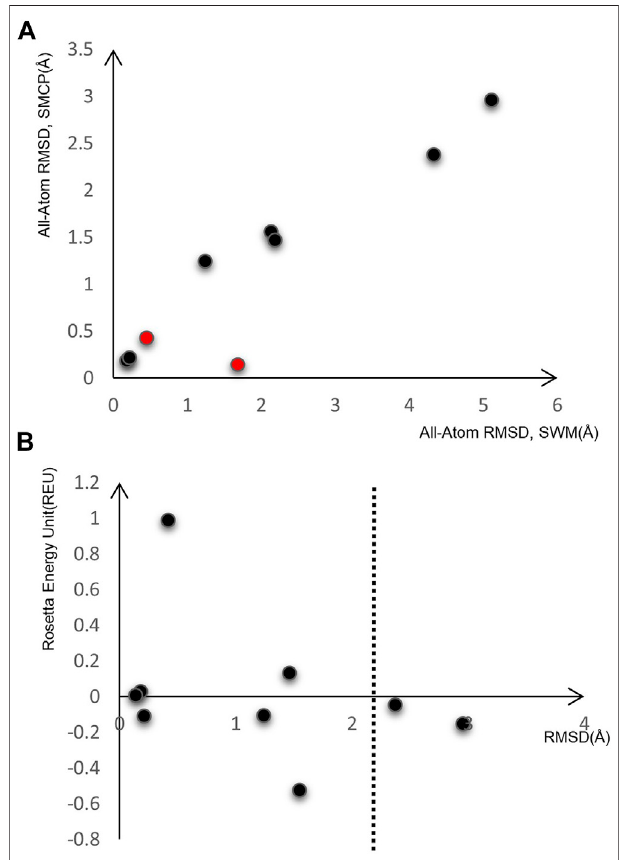
FIGURE 3 | Model on nine RNA motifs. (A) Comparison of modeling RMSD between SWM and SMCP. (B) SMCP modeling